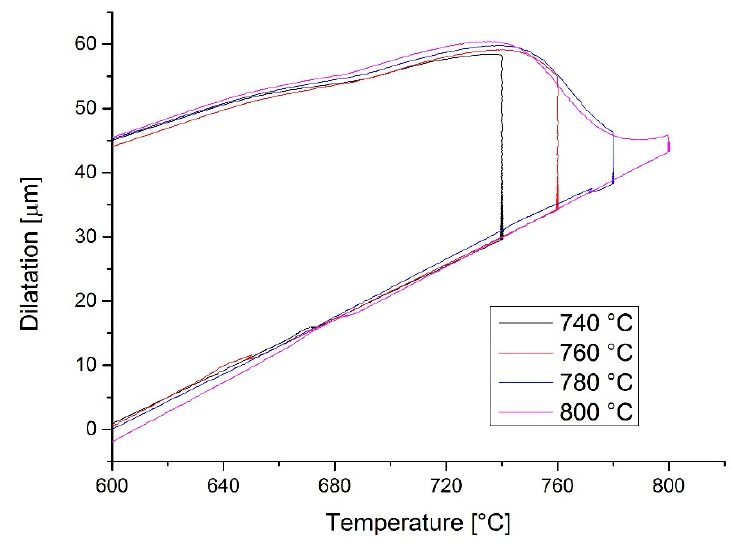
Figure 3. Dilatation at different intercritical annealing temperatures.